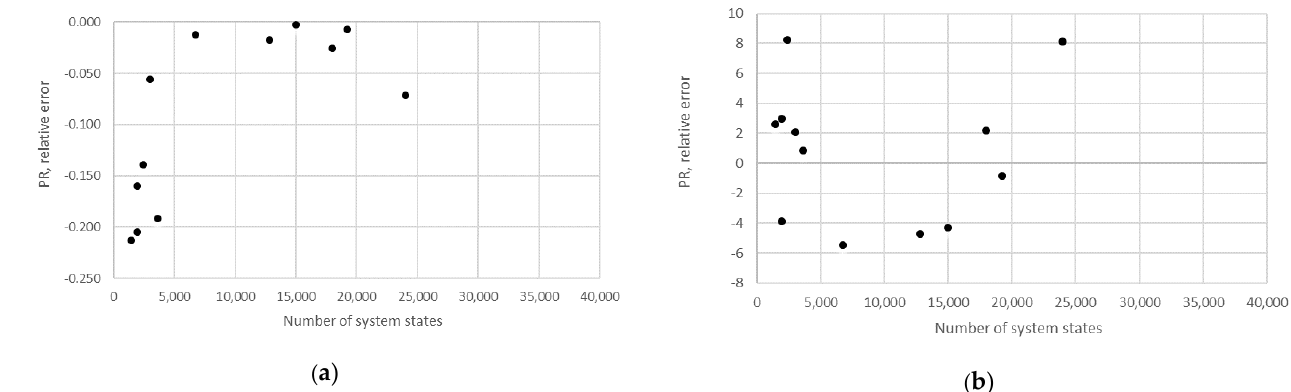
Figure 27. M = 8, relative error obtained using the numerical method—( a ) PR and ( b ) WIP.